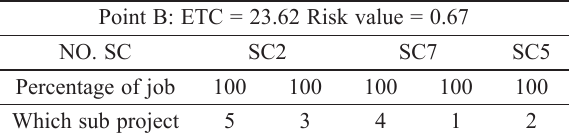
Table 5. Information related to the combination with the lowest risk (Point A) Point B: ETC = 23.62 Risk value =